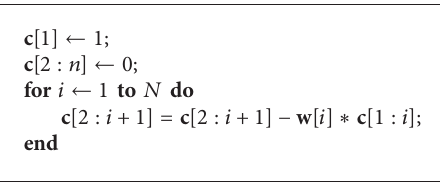
Algorithm 1: Summation Algorithm